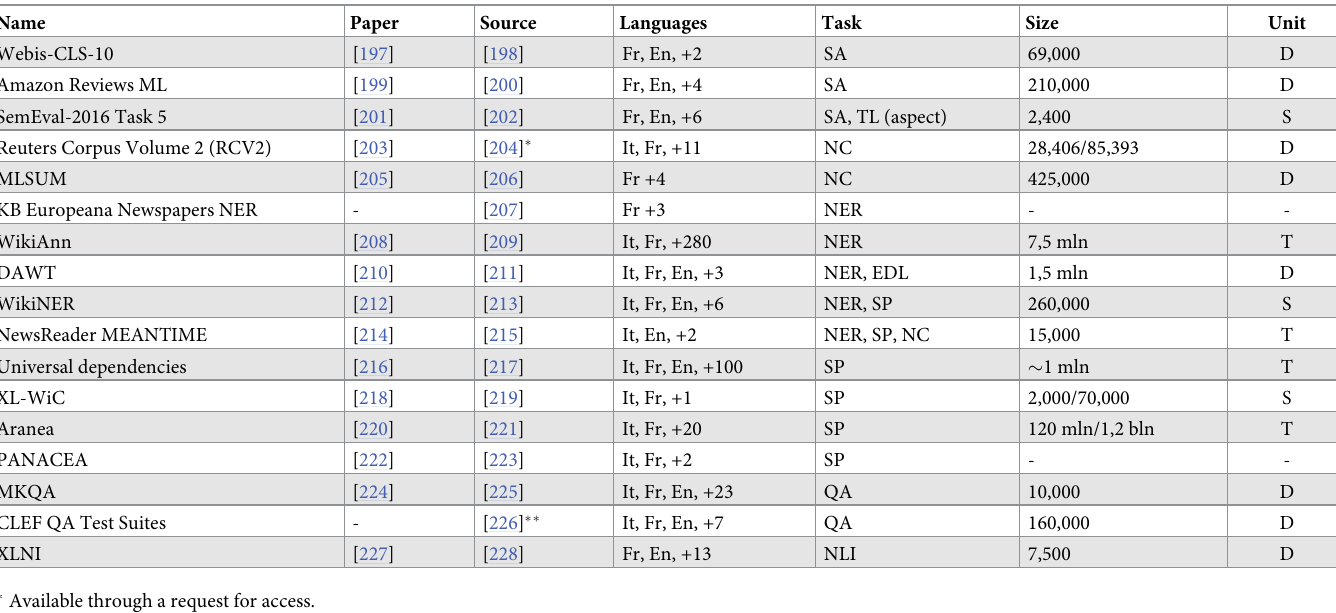
Table 6. Multilingual datasets.